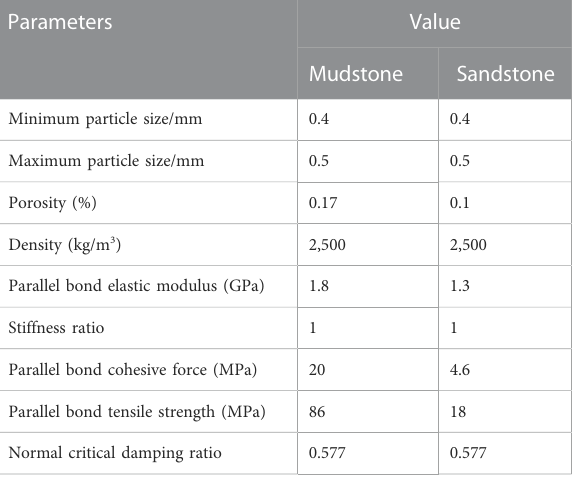
TABLE 4 Calibration results of microscopic parameters of media.